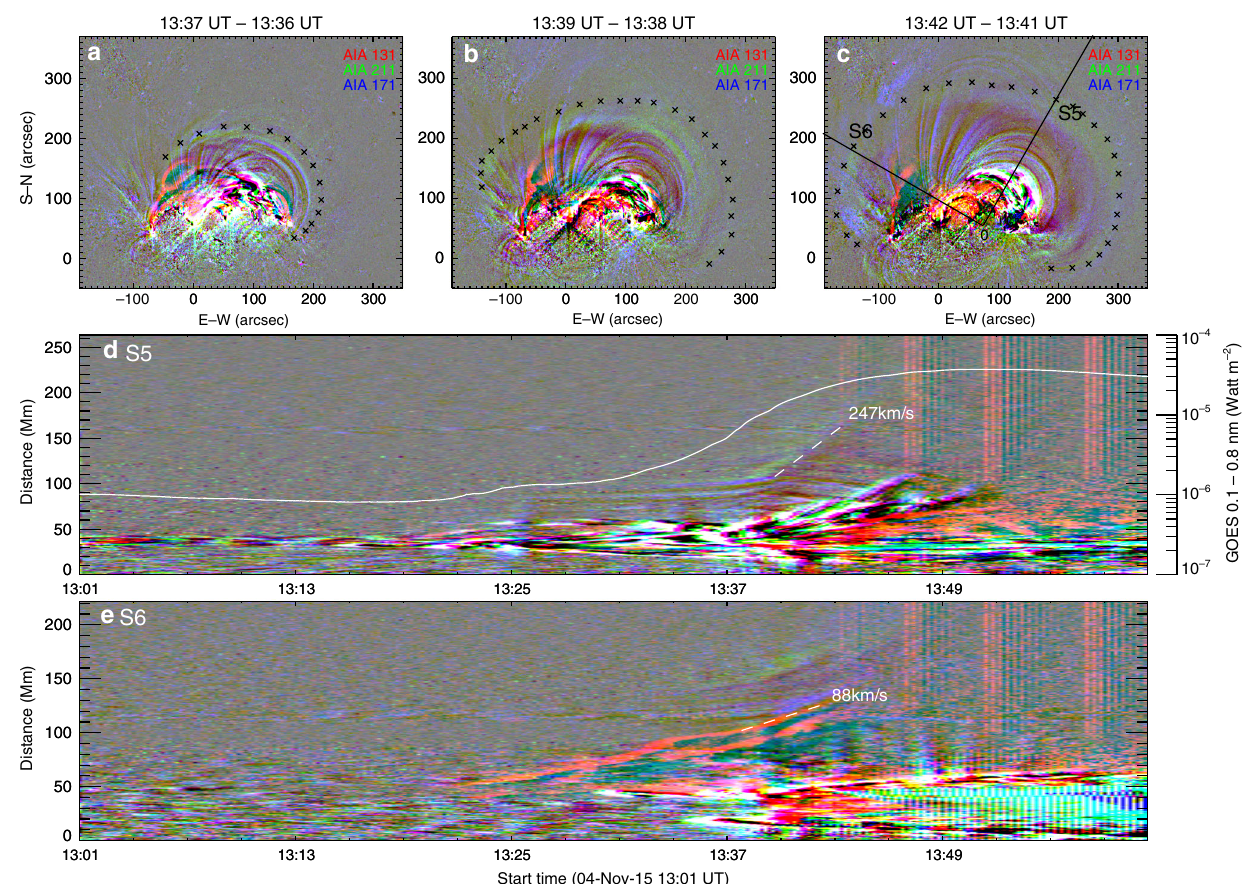
Fig. 5 Eruptive structure in the solar eruption on 4 November 2015. a – c Show composite difference images in three Atmospheric Imaging Assembly (AIA) passbands, 171 (blue), 211 (green), and 131 Å (red). d , e Show the evolution of the eruptive structure as seen through the virtual slits S5 and S6 indicated in c . Linear fi ttings give the projected speeds of the features of interest (marked by dashed lines). The magnetic fl ux rope (MFR) is visible in 131 Å. Its eastern leg possesses a peculiar fork-like feature, which is shown as two semi-parallel red strips in the time-distance map e constructed via the silt S6 that crosses the fork. The wavefront (marked by crosses in a – c ) ahead of the MFR is mainly visible in 171 and 211 Å, therefore appearing